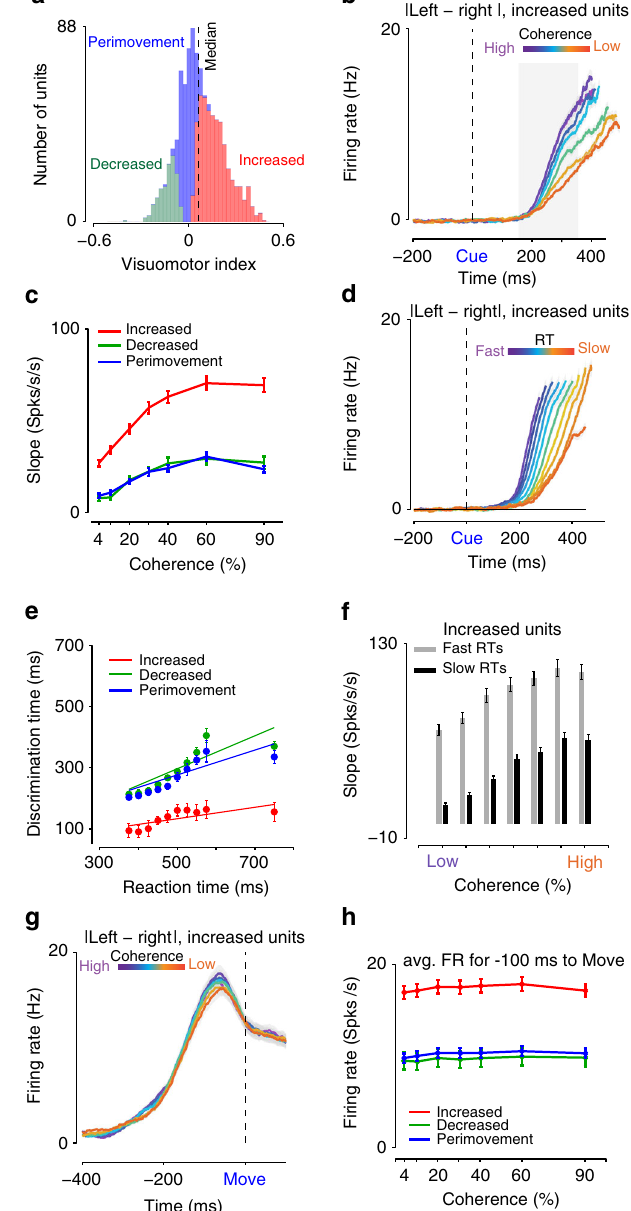
panel of Fig. 2f, see arrow ). We exploited this organization by RT when aligned to movement onset to broadly categorize the units. Fig. 3 Units in PMd that enhance FRs after checkerboard cue onset covaries strongest with the decision process. a Histogram of the visuomotor index demonstrating broad unit categories in PMd. Signi fi cant positive numbers re fl ect increased units ( shaded red , n = 514 units), signi fi cant negative numbers for decreased units ( shaded green , n = 141 units). Intermediate insigni fi cant values of the visuomotor index re fl ect the perimovement structure of these units ( shaded blue , n = 341 units). The index is de fi ned on a per-unit basis and measured as the trial-by-trial correlation coef fi cient between RT and average FR in the − 600 to − 200 ms epoch before movement onset. X -axes depict index; Y -axes the number of units. b Average population level choice selective signal ( | left — right | ) in PMd for the population of increased units ( n = 514 units) as a function of the color coherence aligned to checkerboard cue onset. All trials are included and sorted by the choice of the monkey. The colors ranging from purple to orange depict color coherence (high to low). X -axes depict time in ms; Y -axes depict the FR in Hz. Shaded errors denote SEM over units. For each unit, we also subtracted the absolute difference in baseline FR before averaging. The gray shaded region highlights the 150 – 350 ms epoch used to estimate the slopes plotted in Fig. 3c. c Slope of the choice selectivity signal (as shown in b ) in the 150 – 350 ms epoch (for e.g. demarcated by the shaded gray region in b ) after checkerboard cue onset for increased (514 units), decreased (141 units), and perimovement units (341 units) in PMd for the seven different color coherence levels. Red color denotes increased units. Blue and green colors denote the perimovement and decreased units. Error bars are SEM estimated over units. We compared the slopes of these curves to a slope estimated through shuf fl ing across color coherences. d Average population level choice selective signal ( | left — right | ) in PMd for the increased units ( n = 514 units) as a function of the RT aligned to checkerboard cue onset. Different colored lines here depict different levels of RT; purple colors depict fast RTs, orange colors depict slow RTs. X -axes depict time in ms; Y -axes the FR in Hz. For each unit, we also subtracted the absolute difference between left and right FRs during the hold period for each unit before averaging across units. e The population response of increased units (shown in red ) begins to signal the eventual choice ~100 – 150 ms after checkerboard cue onset regardless of RT. Perimovement (shown in blue , 341 units) and decreased units (shown in green , 141 units) signal choice closer to movement onset. Y -axes plot the discrimination time de fi ned as the fi rst time at which the choice selective signal signi fi cantly departed from the FR before the onset of the checkerboard cue (i.e., the hold period) as estimated using a paired t -test that corrected for multiple comparisons. X -axes depict different RT bins. The error bars on this time estimate are calculated by bootstrapping FRs for each unit and then estimating the latency using this bootstrapped FR distribution for the subpopulation of units. Lines denote regression fi ts of the average latency to the center of the RT bin. f Covariation with RT was observed within a color coherence level for the increased units. For these units, the mean rate of rise of the choice selective signal was faster for faster RTs even within each level of color coherence (for every unit, RTs were split into fast and slow RTs using the median RT). X -axes depict different levels of color coherence. Y -axes the slope of the choice selective signals in the 150 – 350ms after checkerboard cue onset as in c . Error bars denote SEM over units. g When aligned to movement onset, for increased units ( n = 514) the average choice selective signal ~100 ms before movement onset only modestly covaries with color coherence. The colors ranging from purple to orange depict color coherence (high to low). X -axes depict time in ms. Y -axes the magnitude of the choice selectivity signal in Hz. Shaded errors denote SEM. h By the time of movement onset, the average choice selective signal in the − 100 ms to move onset for any of the various broad classes of units in PMd does not strongly change depending on the color coherence of the checkerboard cue. The slopes of the curves are not signi fi cantly different from slopes estimated via shuf fl ing. X -axes depict color coherence in %. Y -axes depict the FR in the − 100 ms to 0 ms before movement